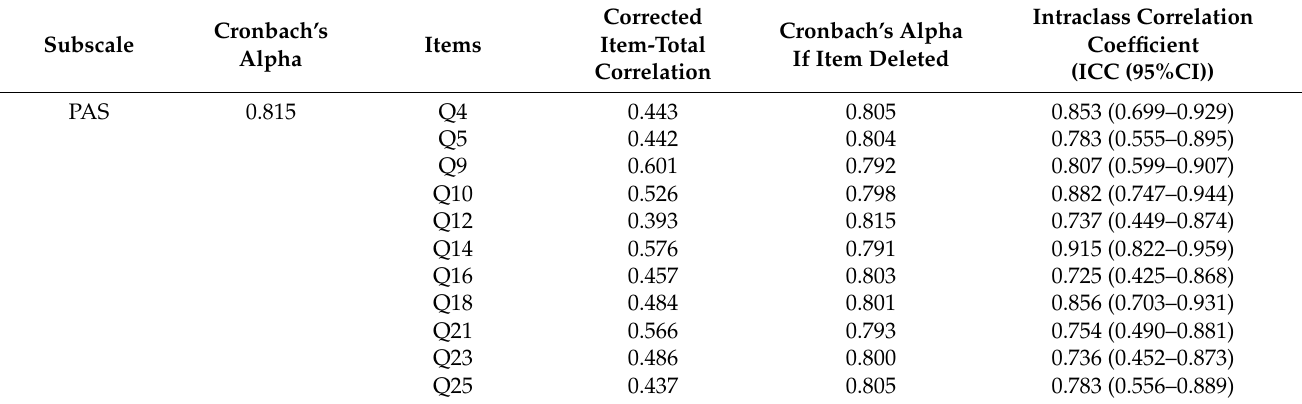
Table 3. Cronbach’s α coefficients for the Positive Attitude Scale (PAS) and Negative Attitude Scale (NAS).